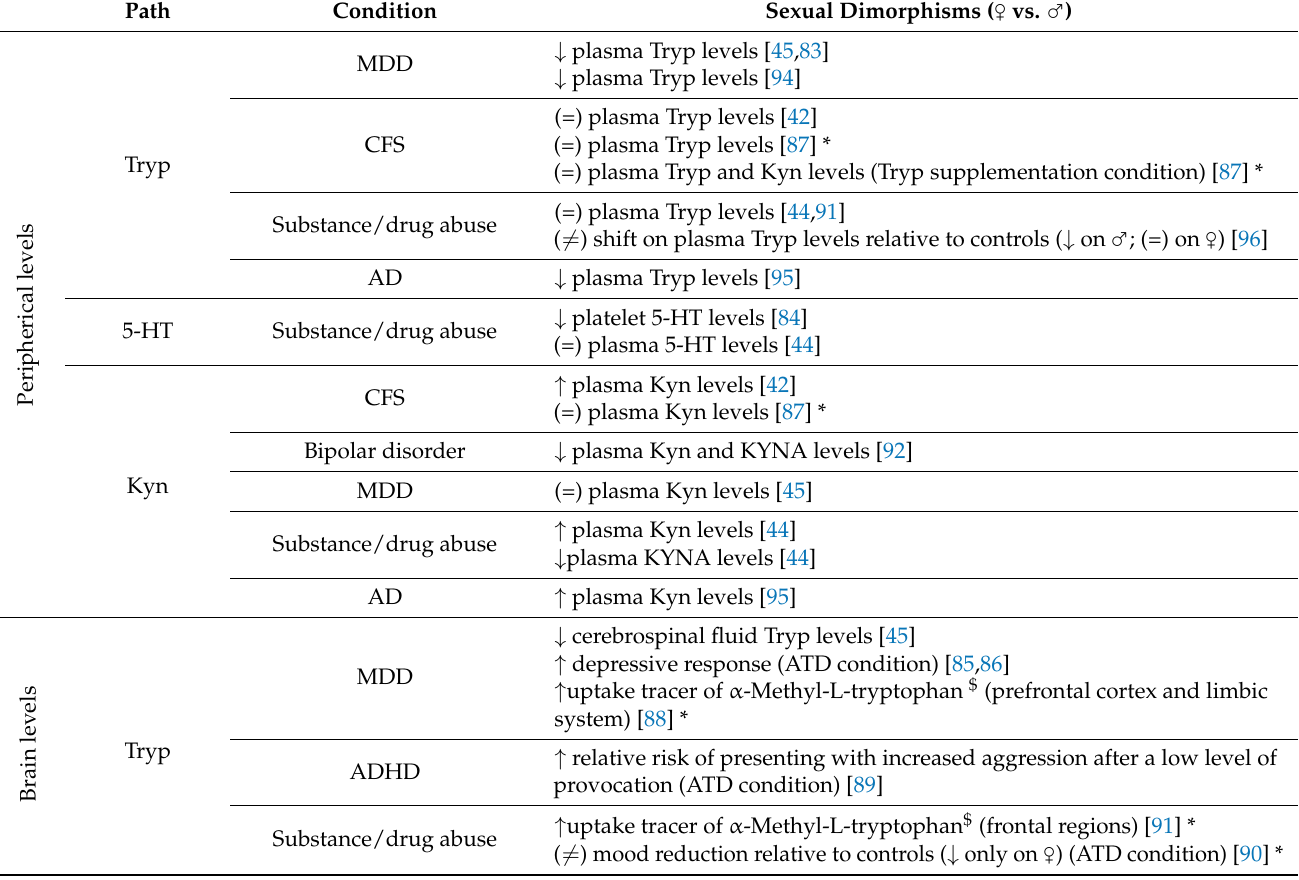
Table 5. Highlights of differences in tryptophan metabolism between sexes: neuropsychiatric